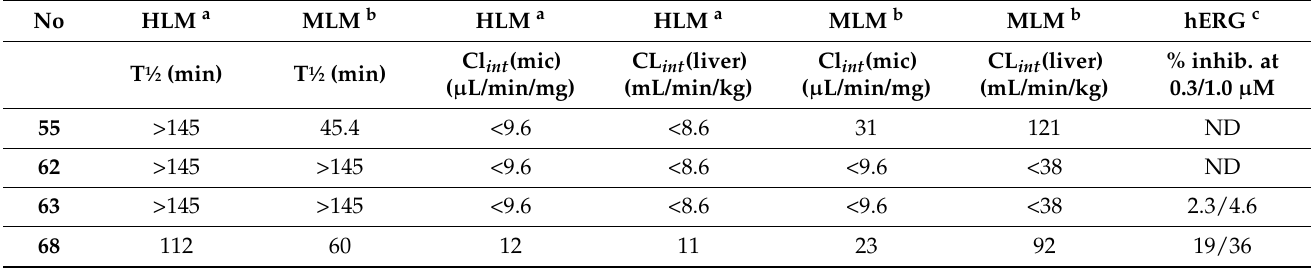
Footnotes for Table 4: a HLM: human liver microsomes. b MLM: mouse liver microsomes. c hERG: %inhibition of the human rapidly activating delayed rectifier potassium channel protein encoded by the